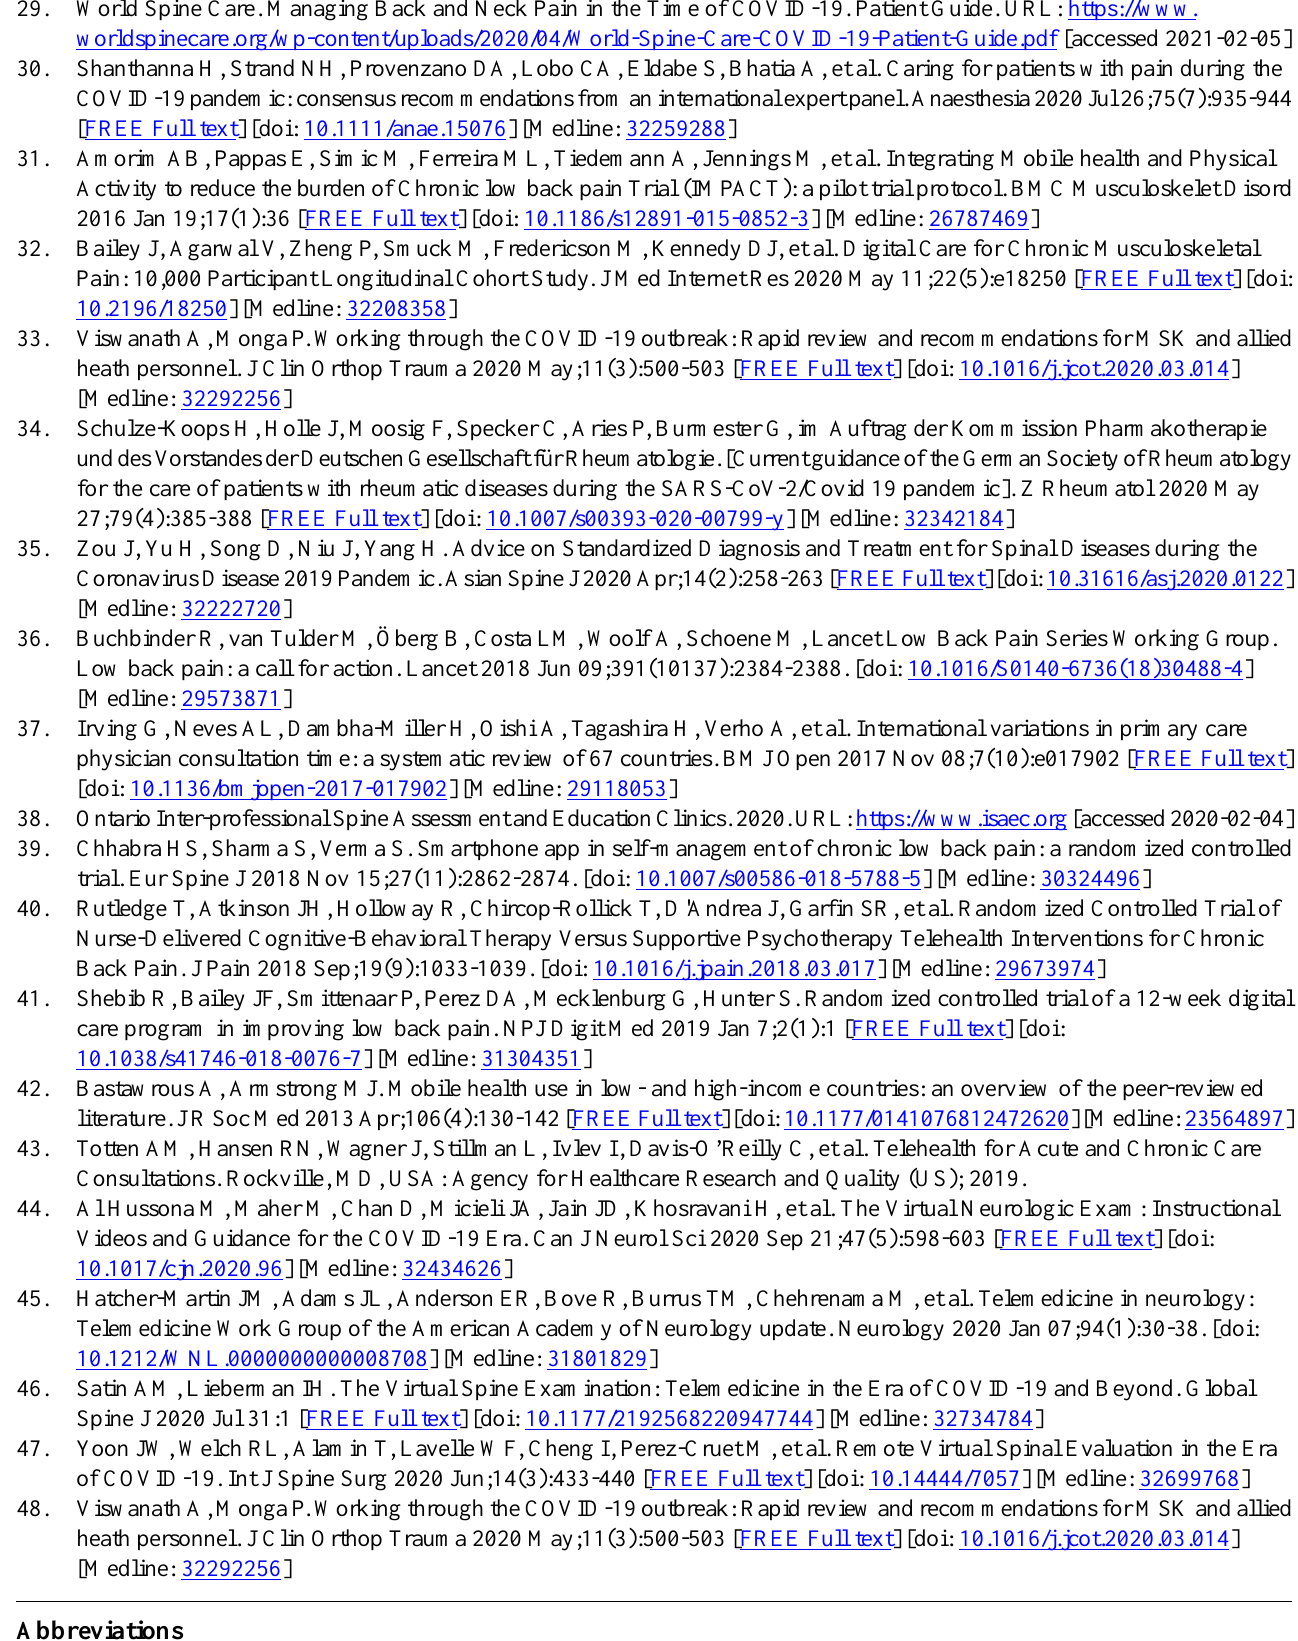
Abbreviations CDC: Centers for Disease Control and Prevention GSCI: Global Spine Care Initiative MRI: magnetic resonance